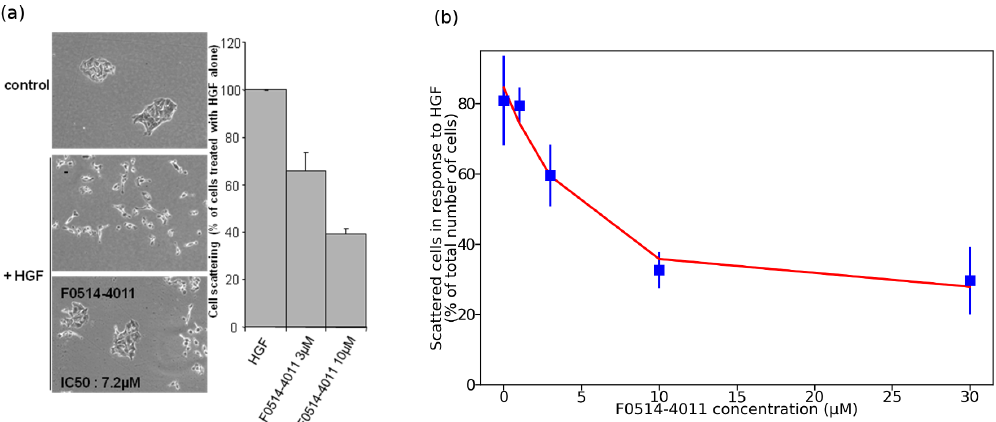
Figure 4. ( a ) F0514-4011 impairs cell scattering in response to MET ligand HGF: MDCK epithelial cells were treated with 20ng/mL HGF, with or without preincubation with F0514-4011 for 2 h. F0514-4011 IC 50 is 7.2 µ M. ( b ) Dose-response curve for F0514-4011.